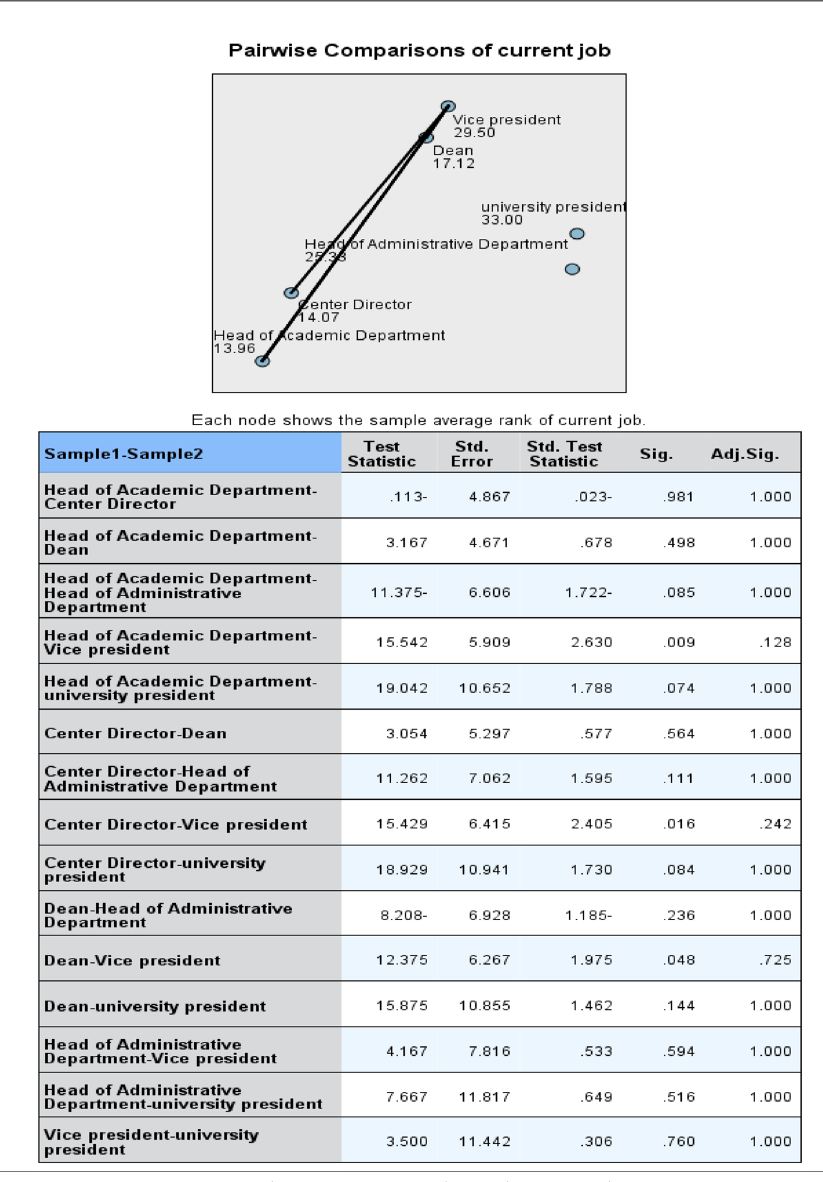
Fig. 3 Pairwise comparisons towards environment according to the current